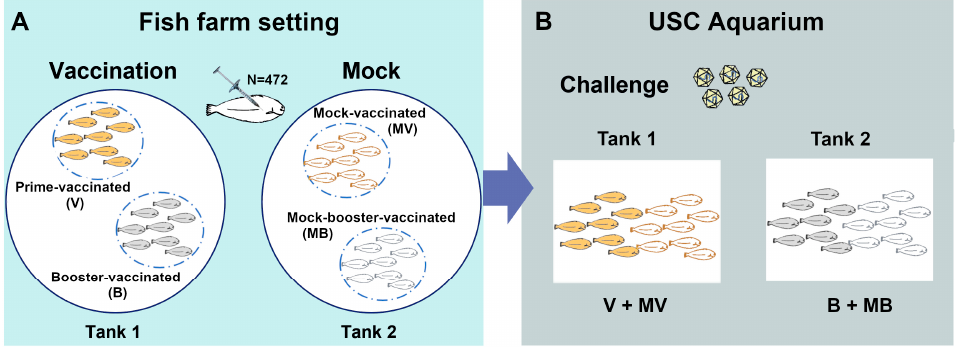
Figure 1. Vaccination and challenge conditions. Fish vaccination was performed in a fish farm ( A ). After prime vaccination or booster, fish were transported to the USC aquarium facilities for challenge ( B ).